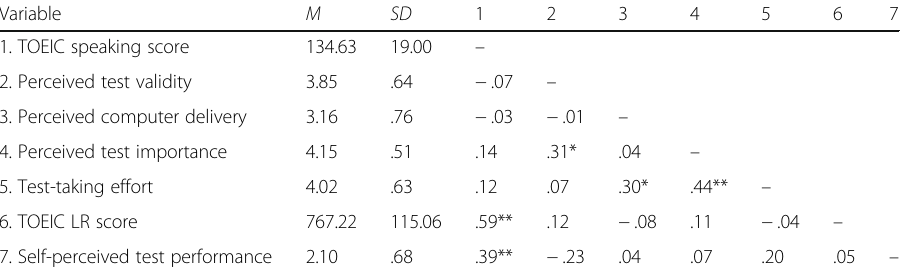
Table 3 Summary of mean, standard deviations, and intercorrelations for scores on the examined variables Variable